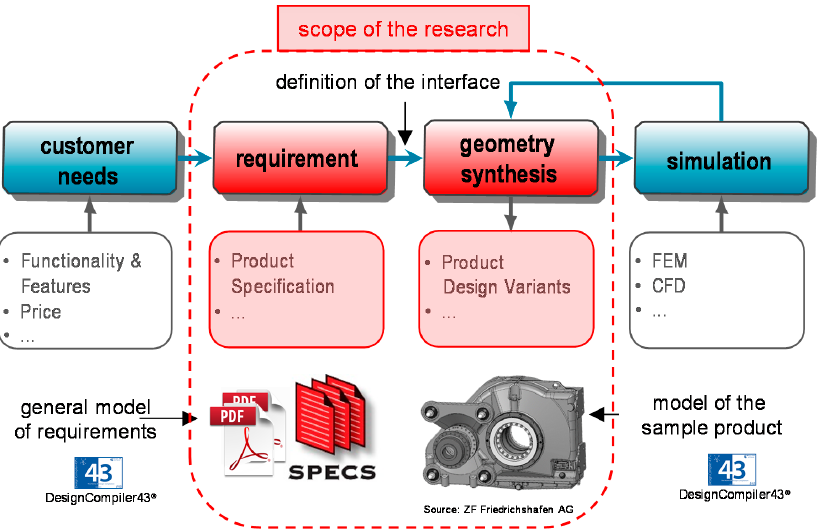
Figure 1. Clarification of the scope of the research.